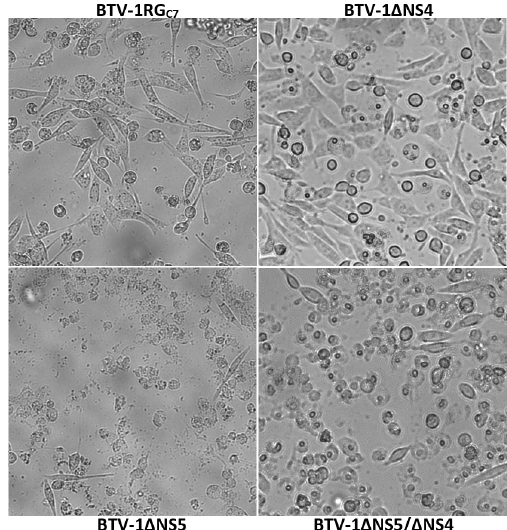
Figure 13. Light microscopy of BSR cell monolayers infected with BTV-1RG C7 , BTV-1 ∆ NS5, BTV- 1 ∆ NS4, or BTV-1 ∆ NS5/ ∆ NS4. BSR cell monolayers were infected with BTV-1RG C7 (derived by re- verse genetics from the wild type BTV1-RSArrrr/01), BTV-1 ∆ NS5, BTV-1 ∆ NS4 or BTV-1 ∆ NS5/ ∆ NS4 and monitored by light microscopy. The images shown were taken 48 h post-infection. Cells infected with BTV-1RG C7 or BTV-1 ∆ NS4 are significantly less lysed than cells infected with BTV-1 ∆ NS5 or BTV-1 ∆ NS5/ ∆